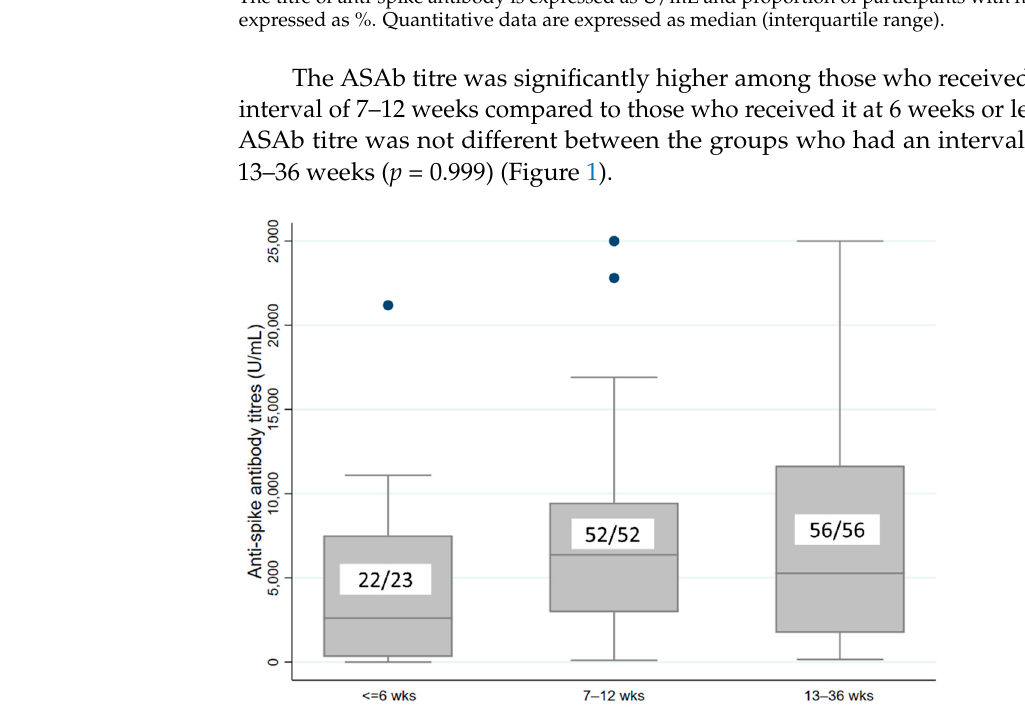
Figure 1. Boxplot comparing the COVID-19 anti-spike antibody titre (U/mL) between the participants who received two doses of vaccine at different intervals. The numbers inside the boxplot show the participants who developed antibodies (numerator) and total number of participant (denominator) in each group.